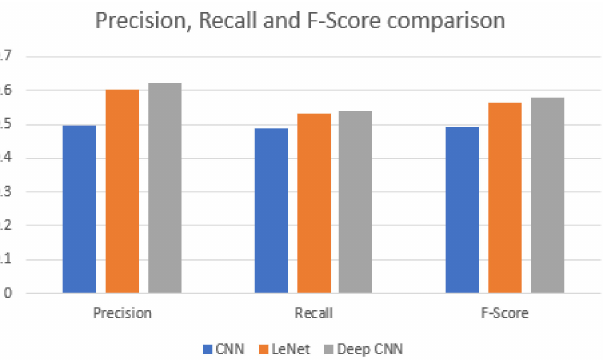
Figure 17. Precision, Recall, and F 1 -Score Comparison of CNN, LeNet, and the Proposed DCNN on the Combined Pashto Digit and Character